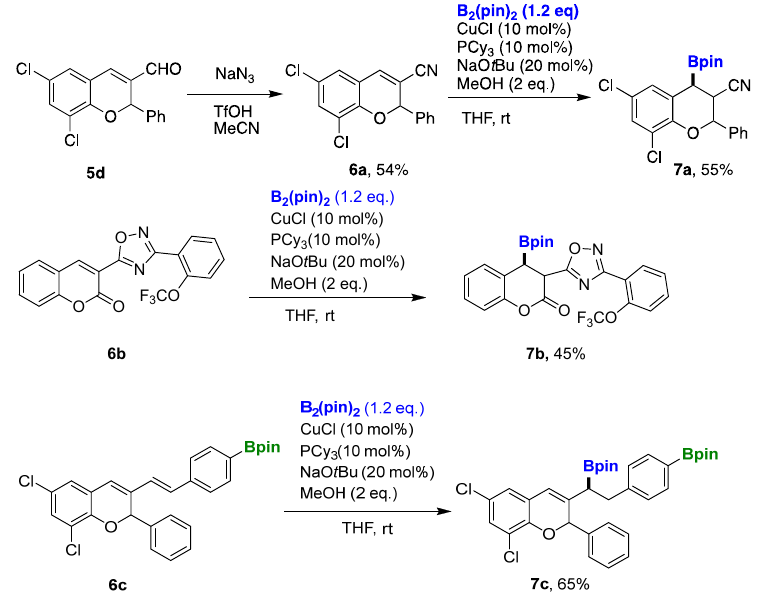
Scheme 5. Application of dearomative borylation strategy for the synthesis of boron ‐ containing